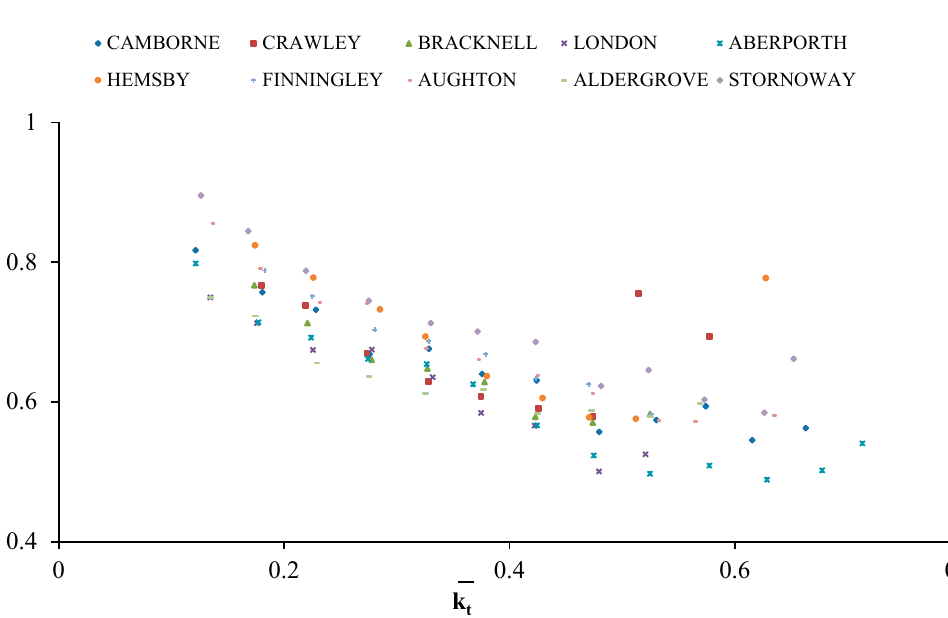
Figure 10. Average values of the k for cities in the 20°–42° N.